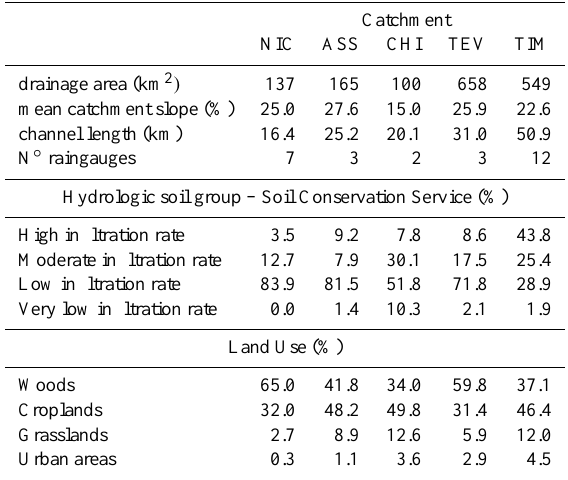
Table 1. – Main characteristics of the five investigated